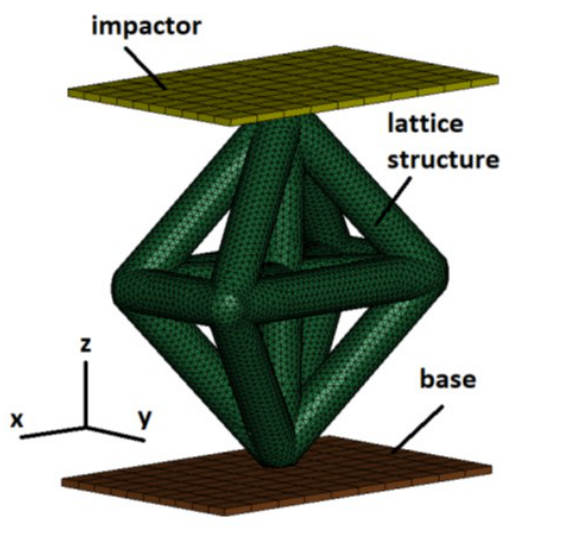
Figure 4. Numerical Simulation